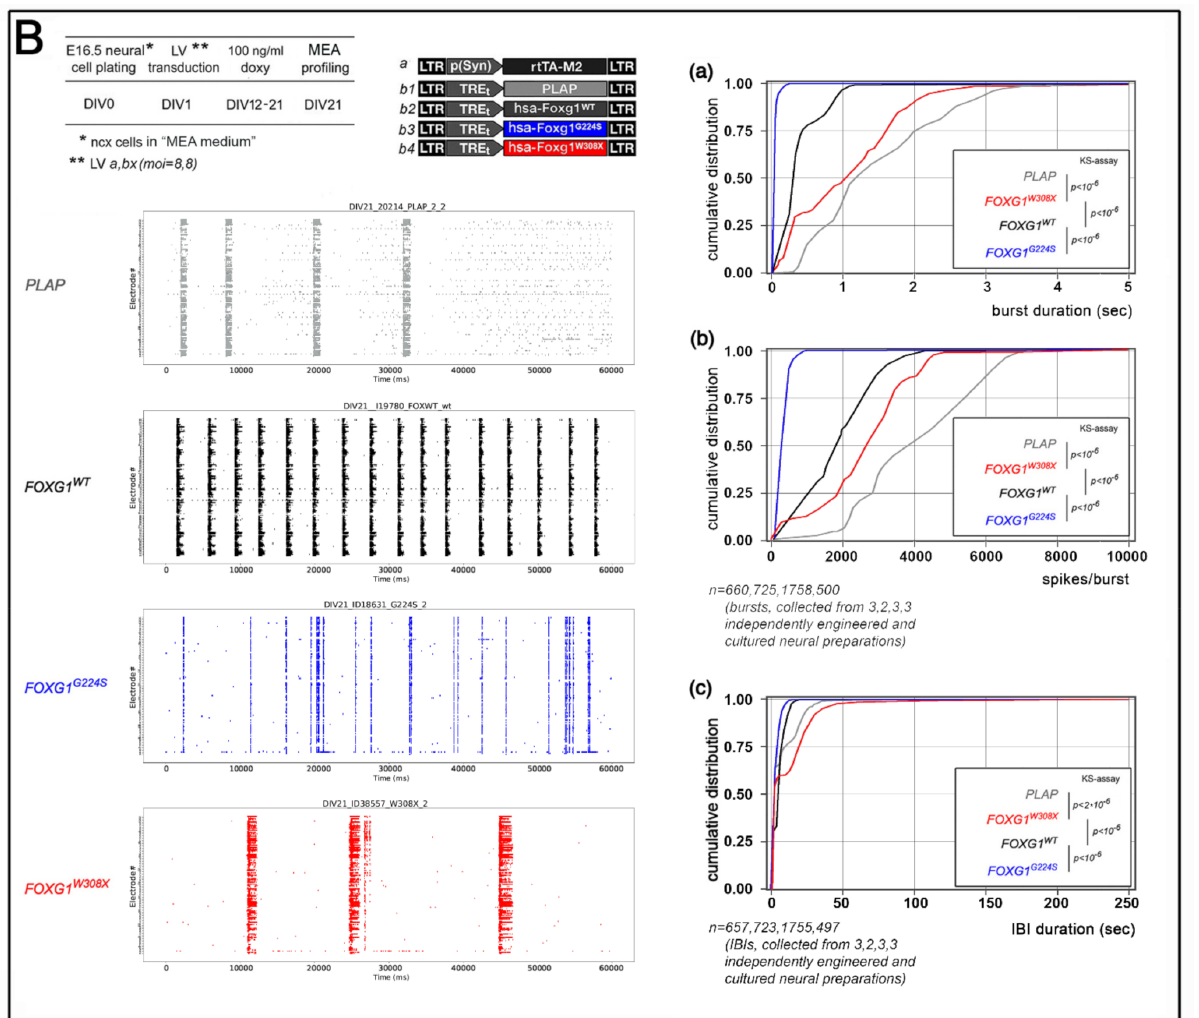
Figure 4. Impact of mutant FOXG1 alleles on neuronal activity. ( A ) Functional profiling of E16.5+DIV10 neocortical neurons, overexpressing Tet ON -controlled, mutant FOXG1 transgenes, by genetically encoded Ca 2+ sensors. Top-left: protocols and lentiviral vectors employed; bottom-left: il- lustrative examples of neuronal Ca 2+ traces; right: results. Shown are: ( a ) average prevalence of active neurons; ( b ) median frequency of Ca 2+ events (evaluation restricted to active neurons); and ( c ) cu- mulative distribution of inter-Ca 2+ events-intervals (IEIs). In ( a ) and ( b ), data normalized against Plap -expressing controls (absolute average prevalence of active neurons among Plap -expressing ones = 0.52; absolute median frequency of Ca 2+ events in Plap -expressing neurons = 0.22 Hz). Sta- tistical evaluation of results: in ( a ) and ( b ), by t -test (one-tailed, unpaired, by Excel software); in ( c ), by Kolmogorov–Smirnov test. n is the number of biological replicates, i.e.,: in ( a ), the number of independently cultured and engineered preparations originating from a common neural pool; in ( b ), the number of single neurons evenly taken from 3,3,3,3 independently cultured and engineered preparations, originating from a common neural pool; in ( c ), the cumulative number of IEIs collected from ∆ F/F traces of such neurons. Scalebars in ( a ) represent s.e.m’s. ( B ) Functional profiling of E16.5+DIV21 neocortical neurons, overexpressing Tet ON -controlled, mutant FOXG1 transgenes, by multi-electrode arrays (MEA). Top-left: protocols and lentiviral vectors employed; bottom-left: illus- trative examples of MEA raster plots; right: results. Shown are cumulative distributions of: ( a ) burst durations (BDs), ( b ) number of spikes/burst (S/B), and ( c ) inter-burst interval (IBIs). Statistical evaluation of results by Kolmogorov–Smirnov test. n is the cumulative number of bursts ( a , b ) and inter-burst intervals ( c ) collected from 3,2,3,3 independently cultured and engineered preparations, originating from a common neural